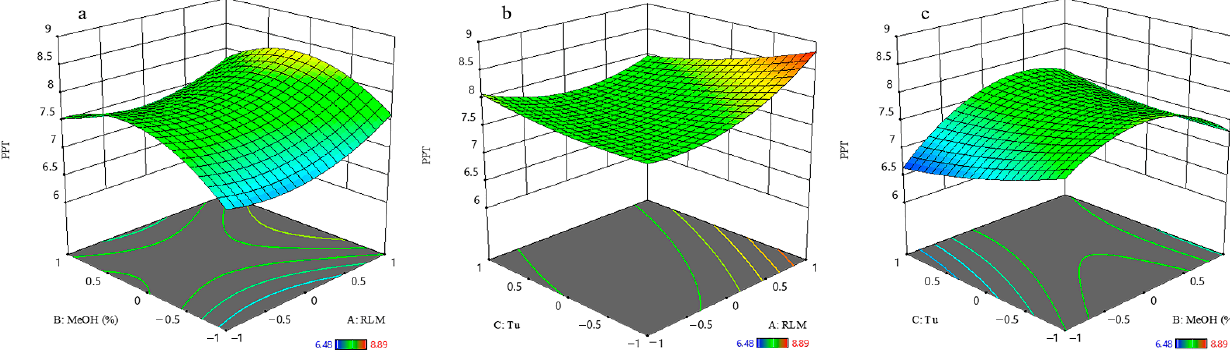
Figure 2. Response surface of podophyllotoxin content: ( a ) as a function of ratio of material to liquid and percentage of methanol; ( b ) as a function of ratio of material to liquid and ultrasonic time; ( c ) as a function of percentage of methanol and ultrasonic